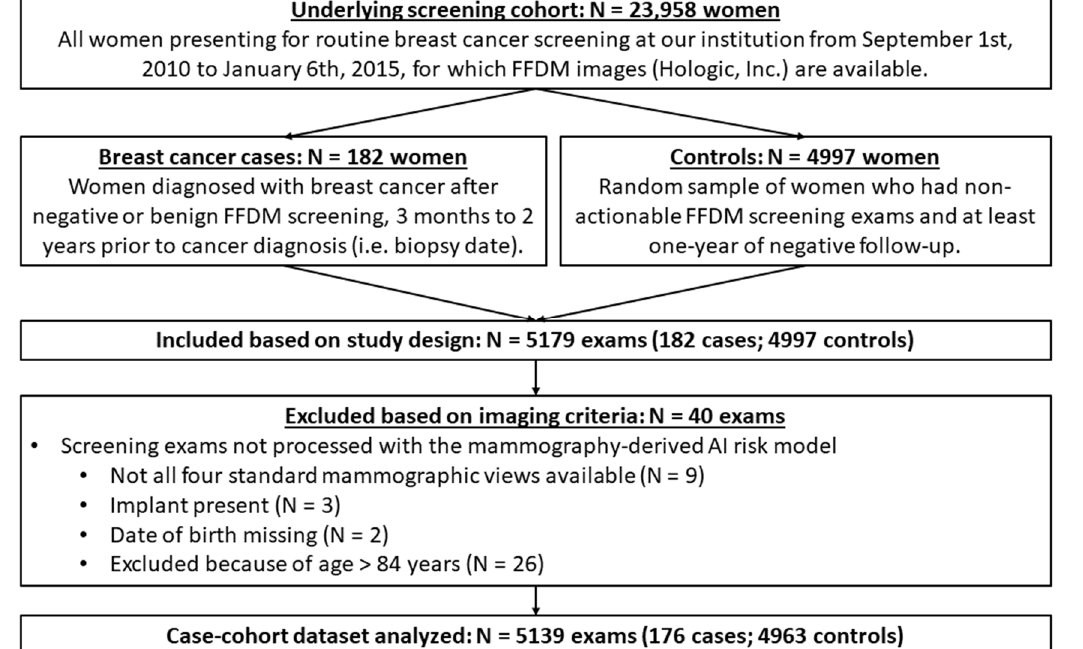
Figure 1. Flowchart showing criteria for case–cohort sample selection. FFDM = full-field digital mammography.